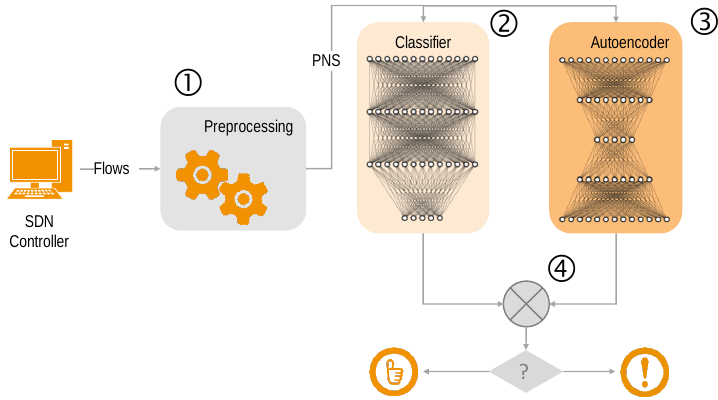
Figure 8. Schematic architecture: ( 1 ) pre-processing module, ( 2 ) classifier, ( 3 ) autoencoder, ( 4 ) aggregation of both models and final